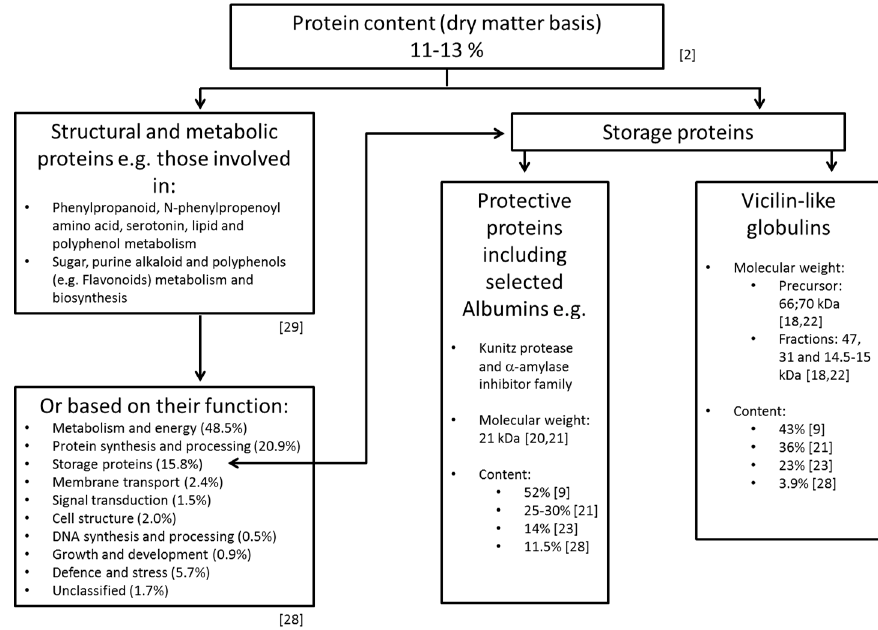
Figure 1. Contemporary classification of cocoa seed proteins [2,9,18,20–23,28,29].